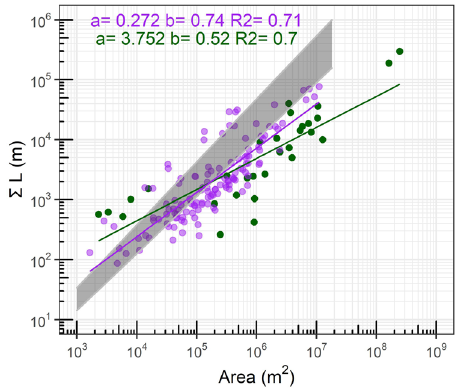
Fig. 3 Channel scaling for mangrove and salt marsh systems. Total network length and watershed area for mangrove and salt marsh watersheds showing a common power law relationship ( ∑ L ¼ aArea b ), for which salt marshes indicate more extensive channel networks at comparable drainage area sizes compared to mangroves. Marani et al. (2003) found a similar relation for sub-basins in Venetian salt marshes which is plotted as a grey area ( ∑ L ¼ 0 : 020 ´ Area 1 ± 0 : 5 ). Salt marsh linear model- fi t: F-statistic: 311.6 on 1 and 126 DF, p -value < 2.2 e − 16 , Mangrove linear model fi t, F-statistic: 66.39 on 1 and 29 DF, p -value < 5.52 e − 9 ; More information on the in fl uence of the correction factor on this relationship can be found in Supplementary Fig. 9d,